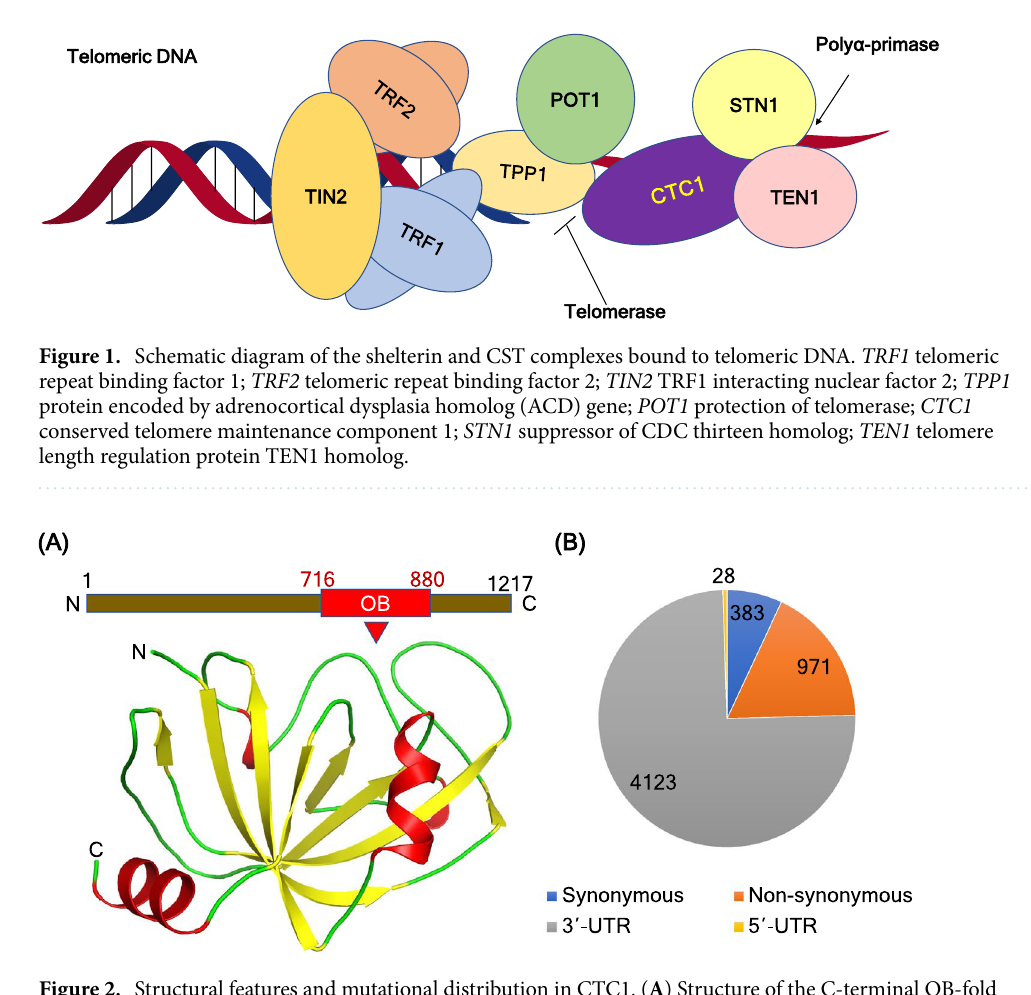
Figure 2. Structural features and mutational distribution in CTC1. ( A ) Structure of the C-terminal OB-fold of CTC1 protein (lower panel) and its position in the protein sequence (upper panel). Figure was drawn using PyMOL (https:// pymol. org/2). ( B ) Representation of the number of SNPs in CTC1 using dbSNP